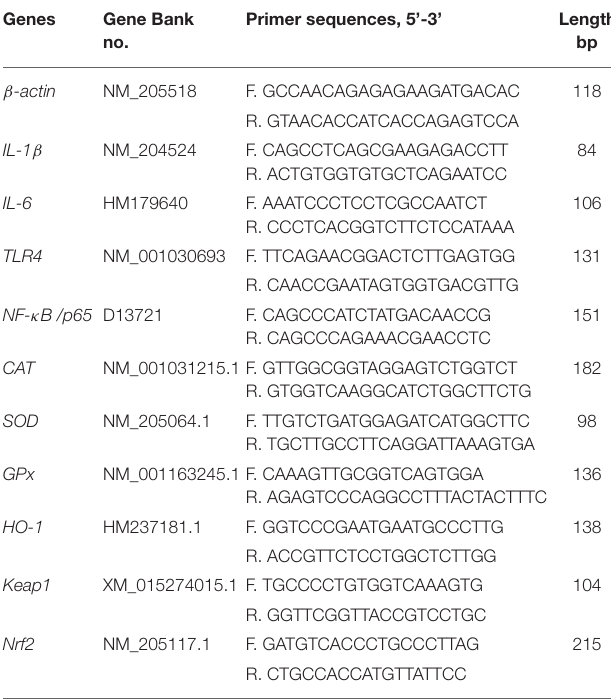
TABLE 2 | Primer sequences and